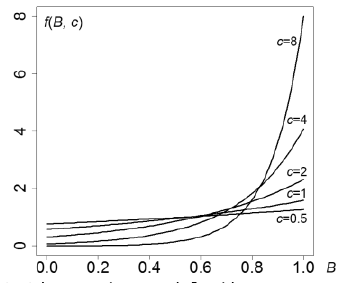
Figure 3. Observation model with parameter B and